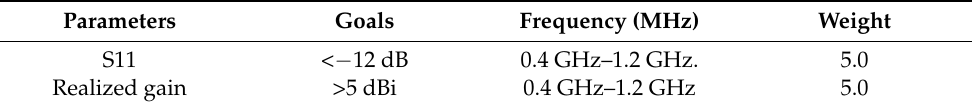
Table 3. Optimization goals.